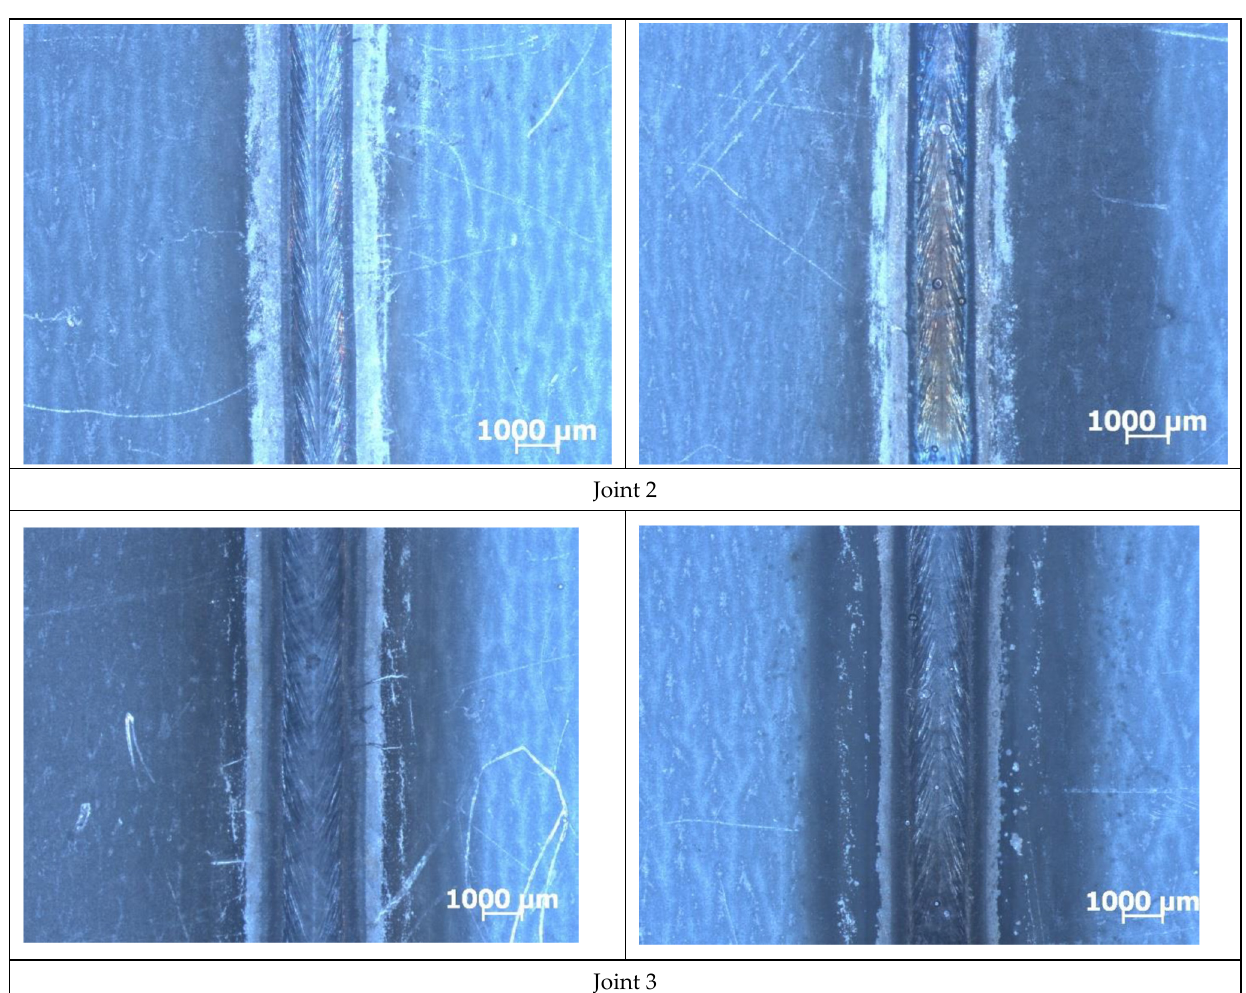
Figure 1. View of welded joints from the weld face and weld root side, welding parameters and joint markings in accordance with the data in Table 3. Table 3. Parameters of the welding process of test joints.